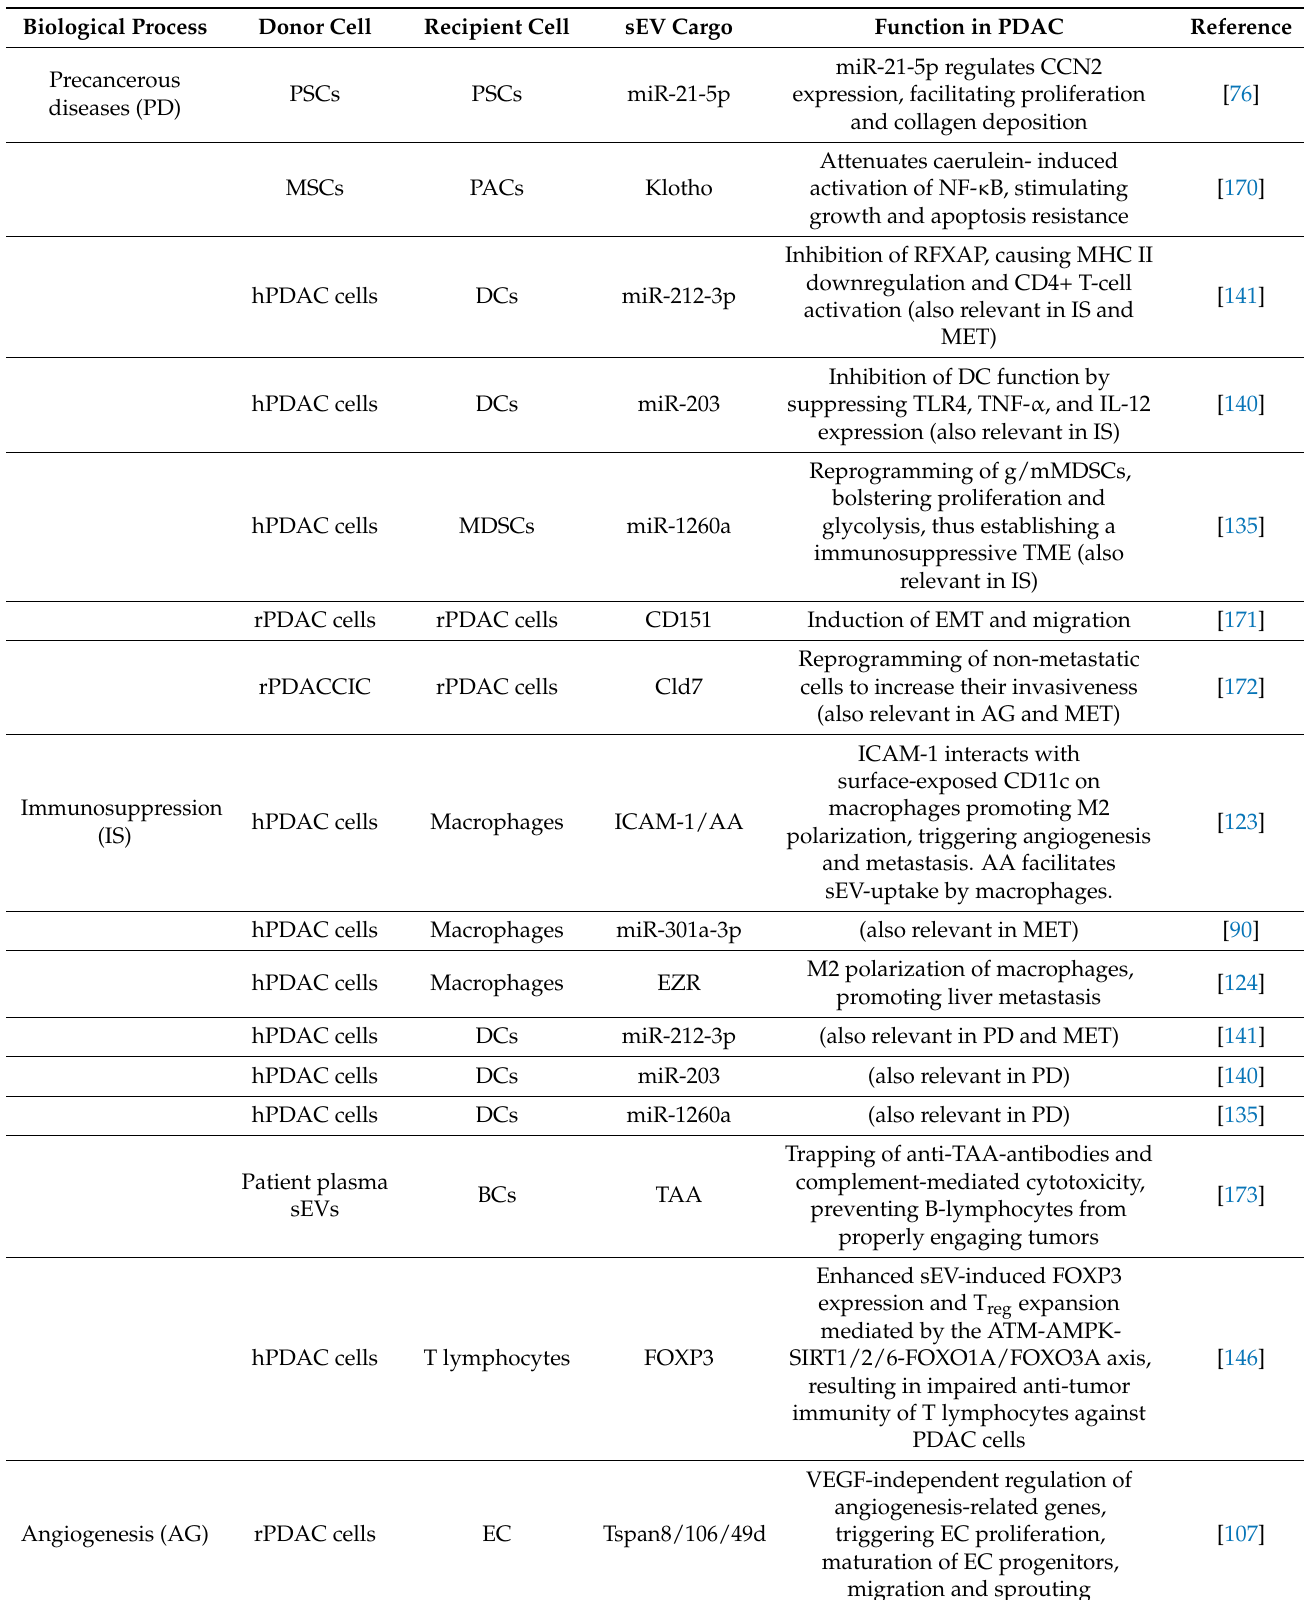
Table 1. sEV cargos and their respective functions in